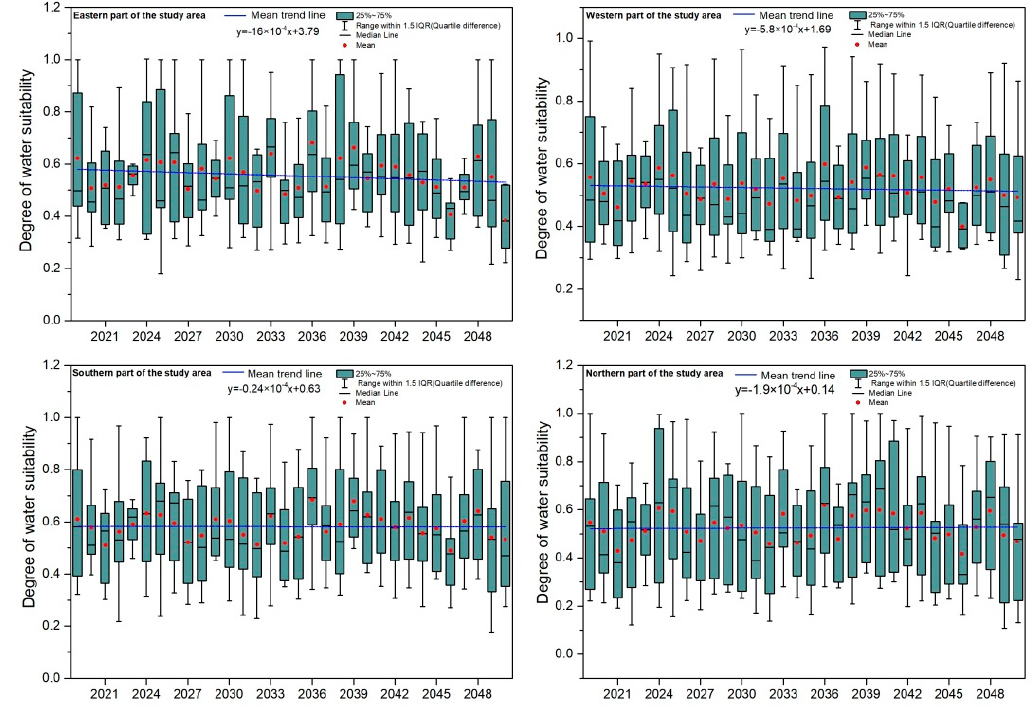
Figure 7. Temporal evolution of water suitability of apple trees in each province from 1990 to 2013.